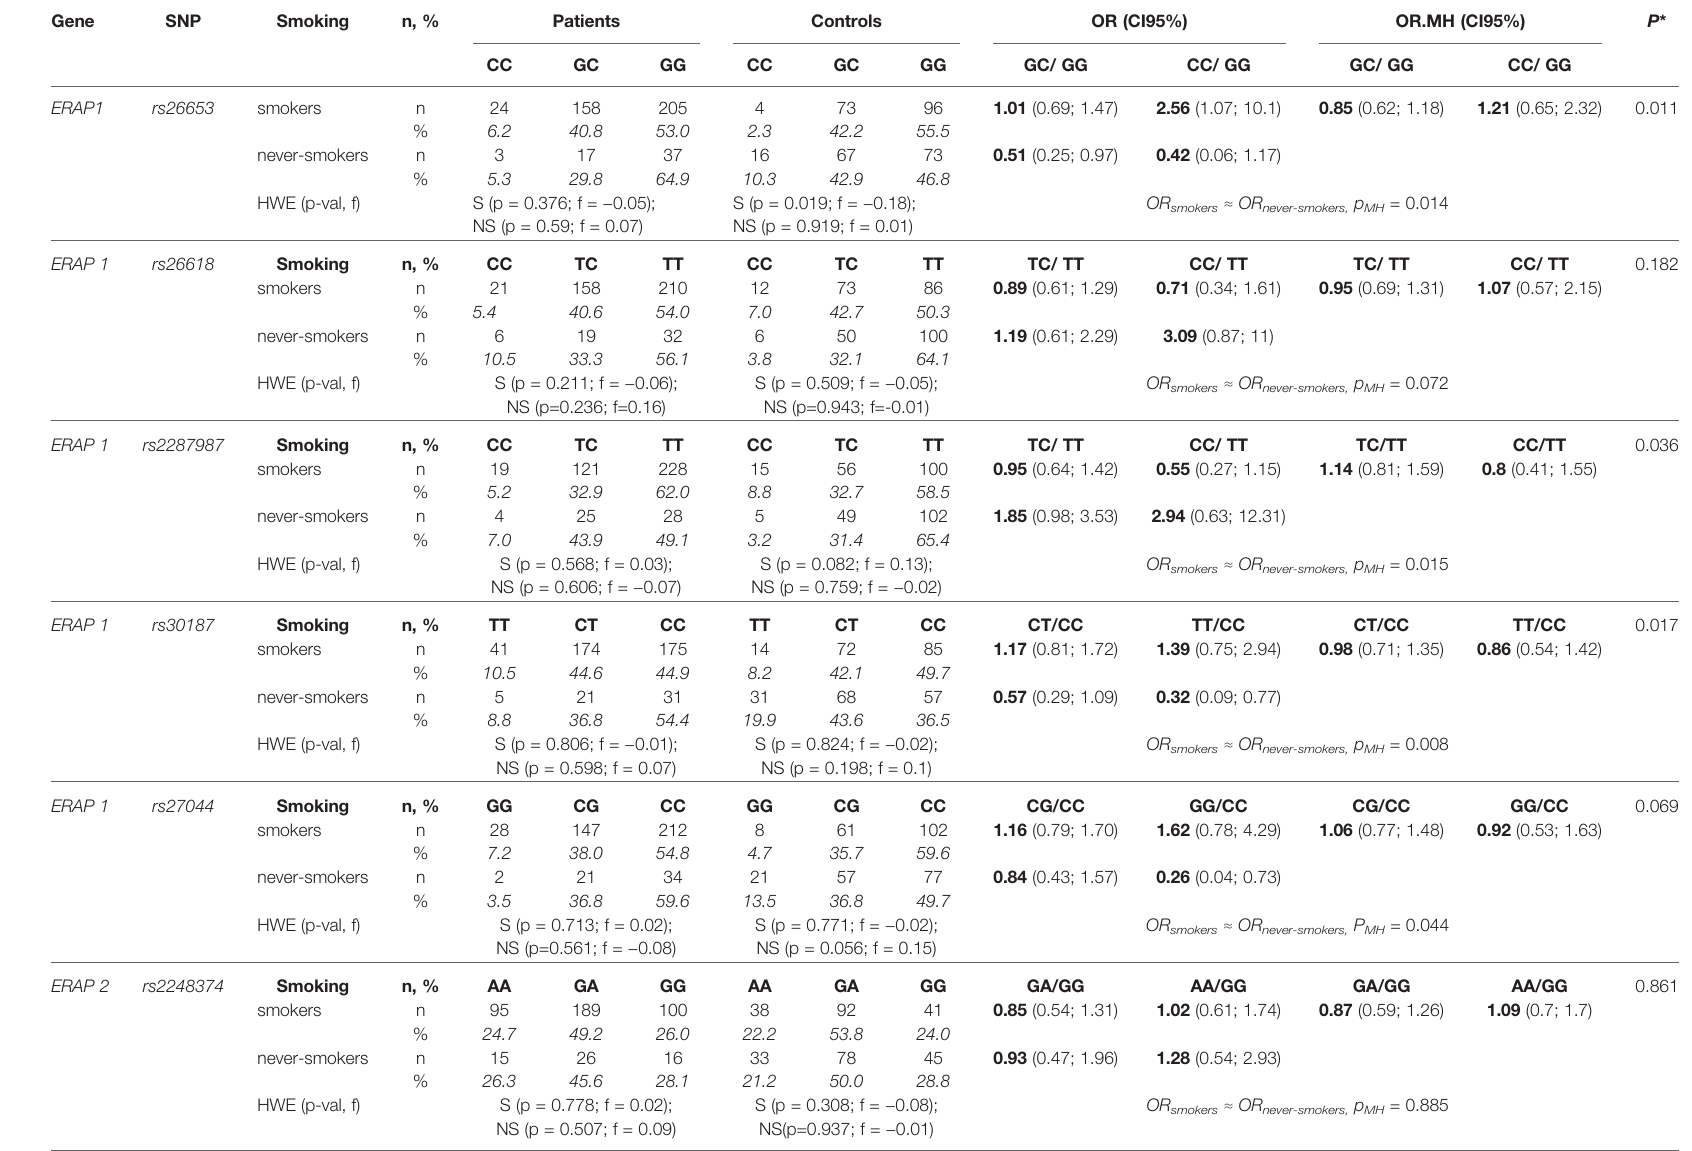
TABLE 2 | Genotypes distributions among NSCLC patients and controls and conditional association between SNP genotype and cancer after adjusting for smoking as the strati fi cation variable. Gene SNP Smoking n, %